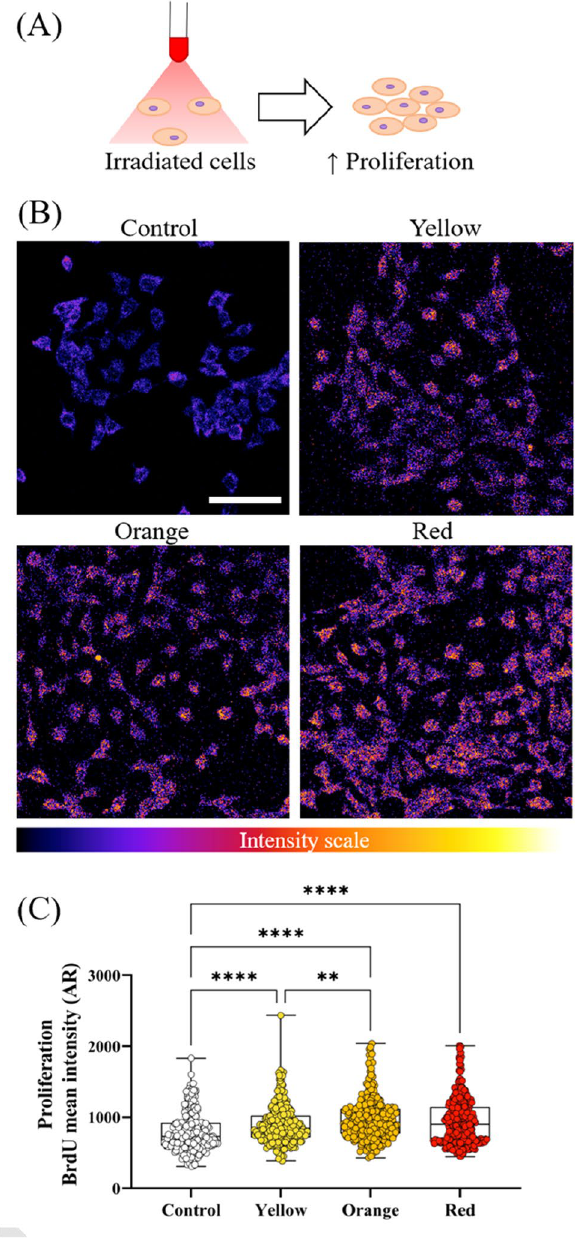
Figure 3. Effect of visible light exposure on HaCaT proliferation. ( A ) Immunofluorescent images of BrdU incorporation into HaCaT cells. BrdU intensity is shown as a colour scale with low intensities appearing more blue and high intensities appearing more purple and orange. ( B ) HaCaT proliferation increases when exposed to visible light. ( C ) Quantitative analysis of BrdU intensity. Each dot represents a single cell and at least 240 cells across four independent experiments have been analysed. Boxes show median, first and third quartiles. Scale bar in B represents 100 μm. **P < 0.01, ****P < 0.0001, ordinary one-way ANOVA multiple comparisons